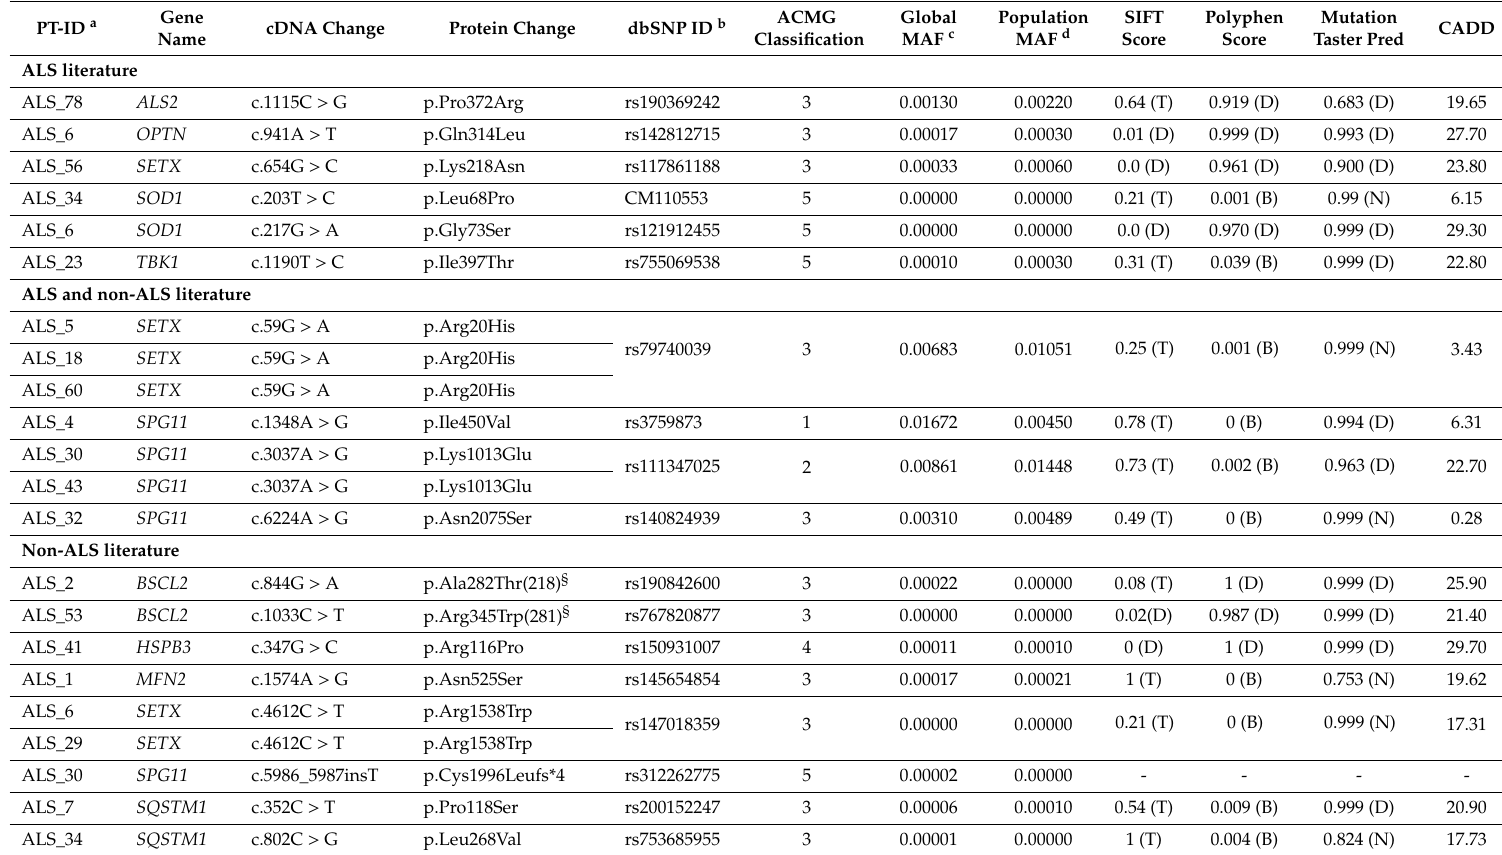
Table 1. Variants identified by next generation sequencing